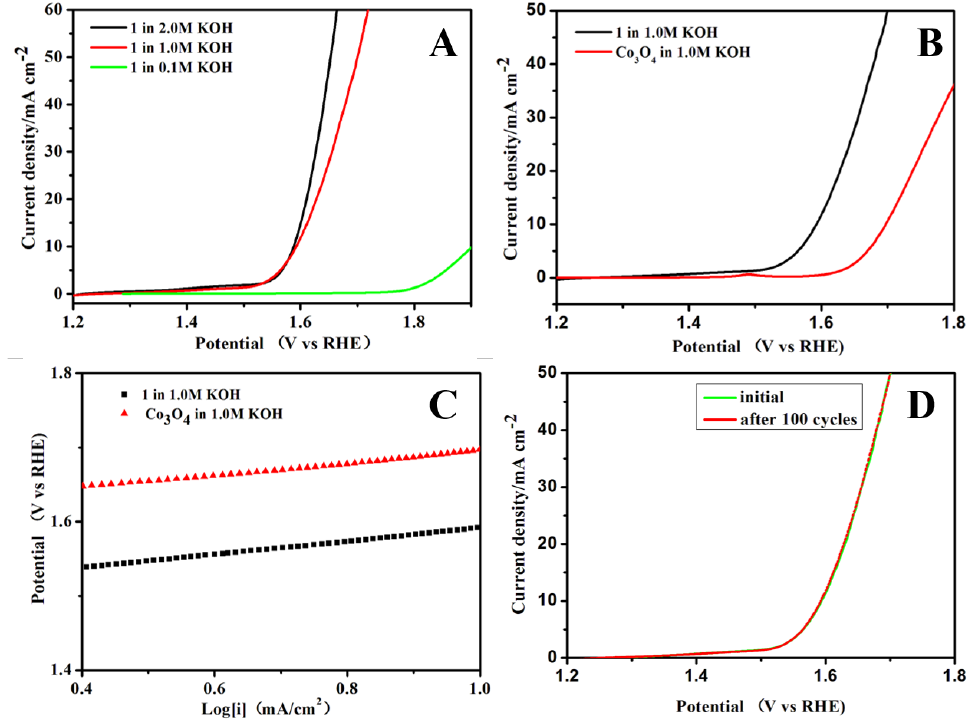
Figure 2. ( A ) Polarization curves of 1 in 0.1 M, 1 M and 2 M KOH; ( B ) polarization curve of 1 and benchmark Co 3 O 4 in 1 M KOH; ( C ) polarization curve derived Tafel plots of 1 and benchmark Co 3 O 4 in 1 M KOH; and ( D ) polarization curves for the 1st and 100th potential cycles of 1 in 1 M KOH.